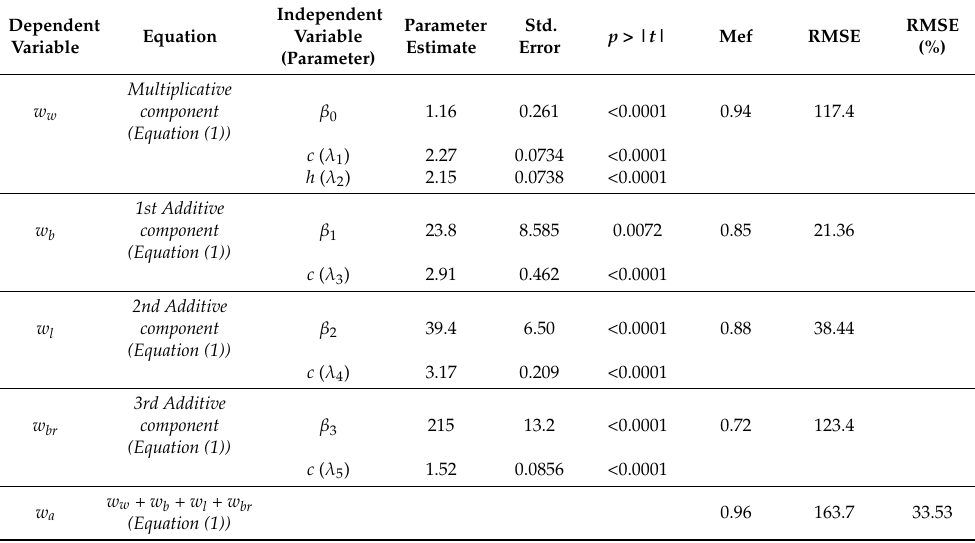
Table 3. Estimated parameters and goodness-of-fit statistics for the model selected for estimating individual tree aboveground biomass.